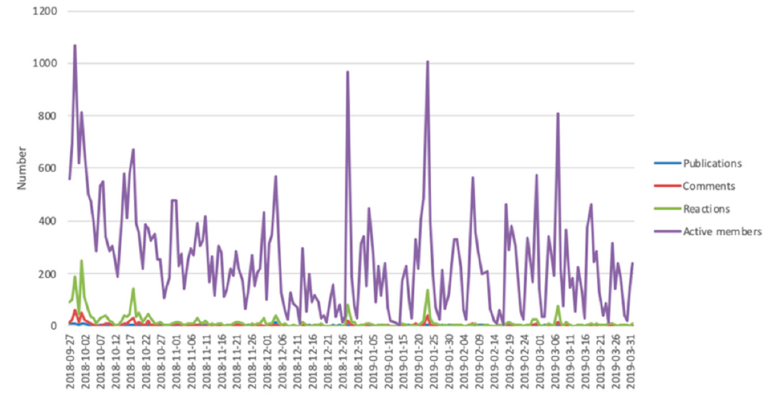
Figure 5. VLC activity after MOOC edition.